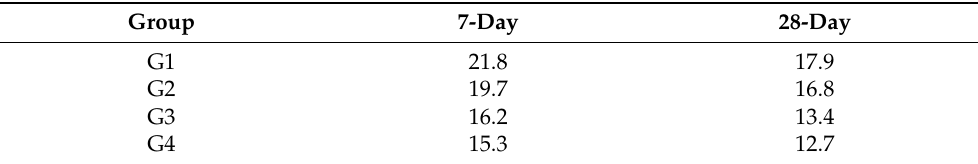
Table 13. Total porosity of the hardened UC-based slurry at 7 and 28